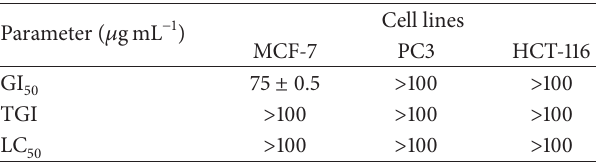
, TGI, and LC ) of C. 50 50 Cell lines MCF-7 PC3 HCT-116 75 ± 0.5 > 100 > 100 > 100 > 100 >